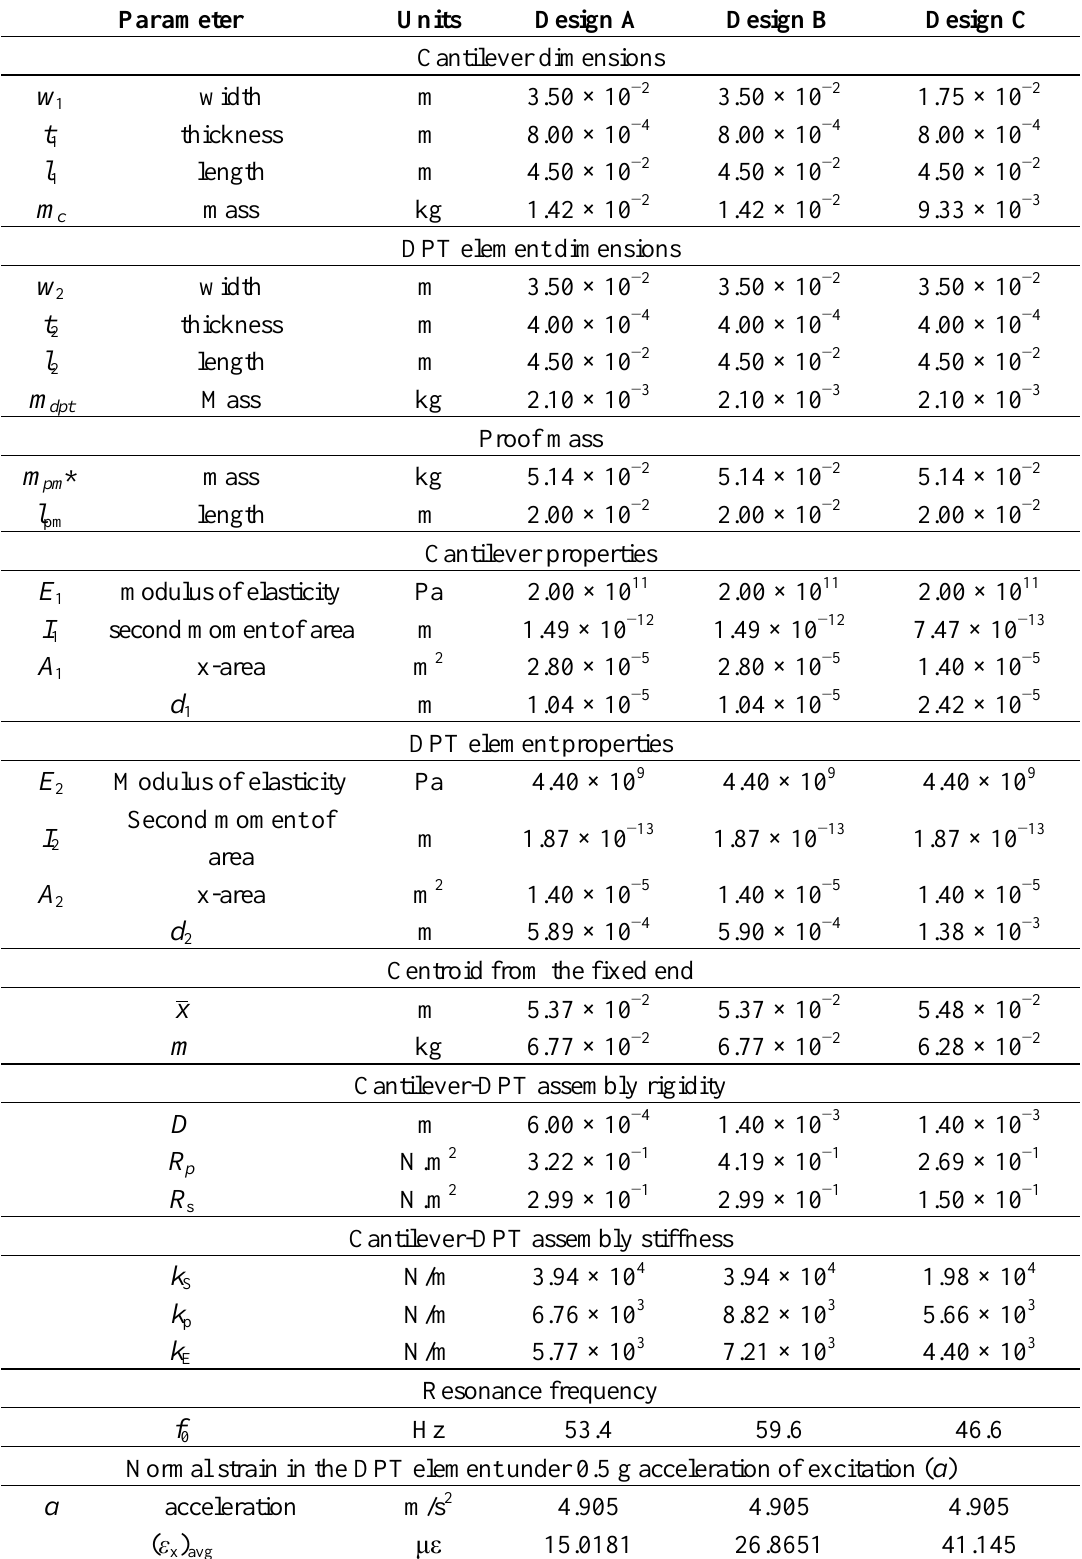
Table 3. Design parameters of the three cantilever-DPT